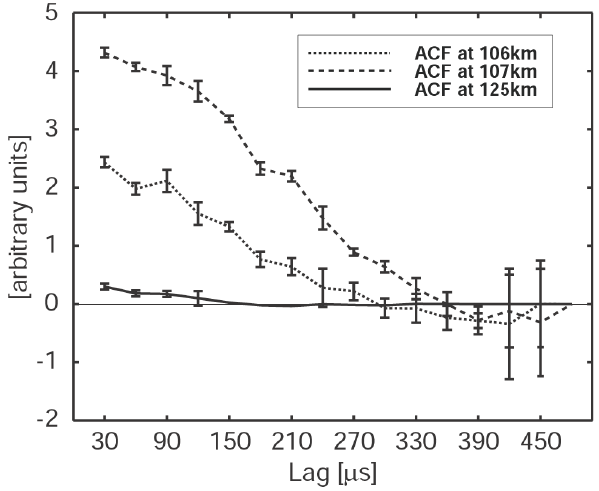
Fig. 6. Real parts of plasma autocorrelation function at selected ranges from the time interval 20:30–20:48